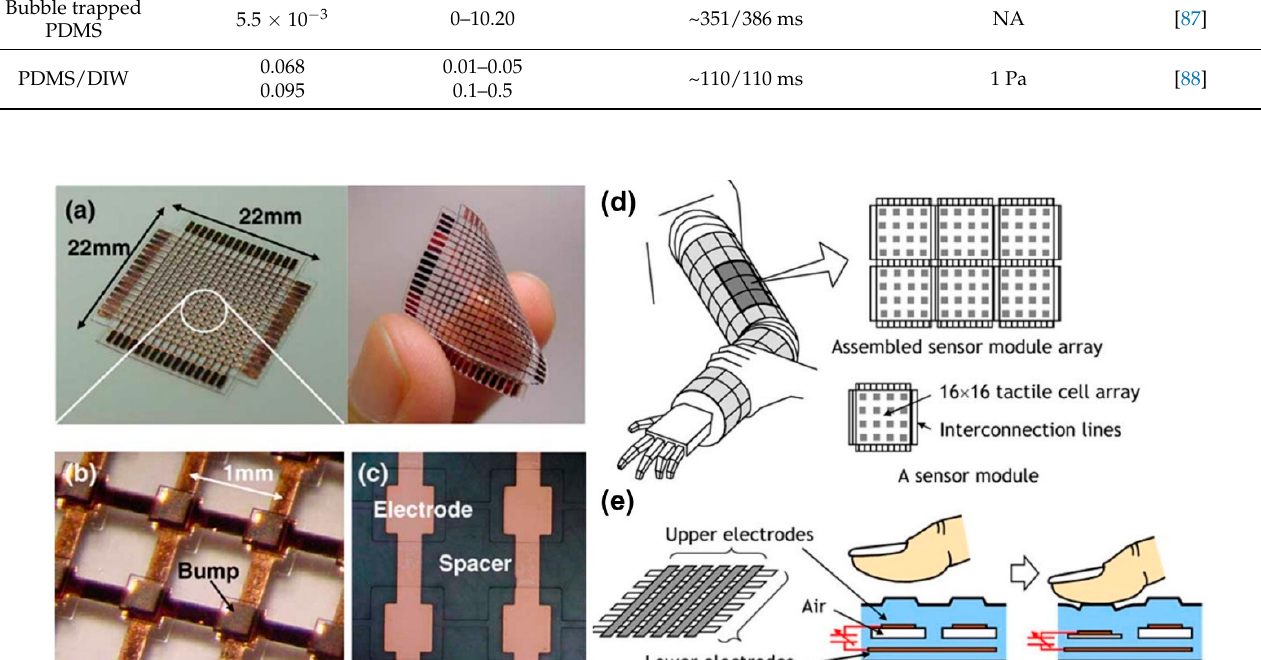
Figure 10. ( a ) Fabricated tactile sensor module, ( b ) magnified view of cells and ( c ) the bottom elec- trodes and spacer layer of four tactile cells. Schematic diagram of the proposed modular expandable tactile sensor: ( d ) sensor module array and ( e ) structure of single tactile cell. The tactile cell capaci- tance changes as the air gap is squeezed according to applied force. Reprinted/adapted with per- mission from Ref. [74]. Copyright 2006, IEEE.